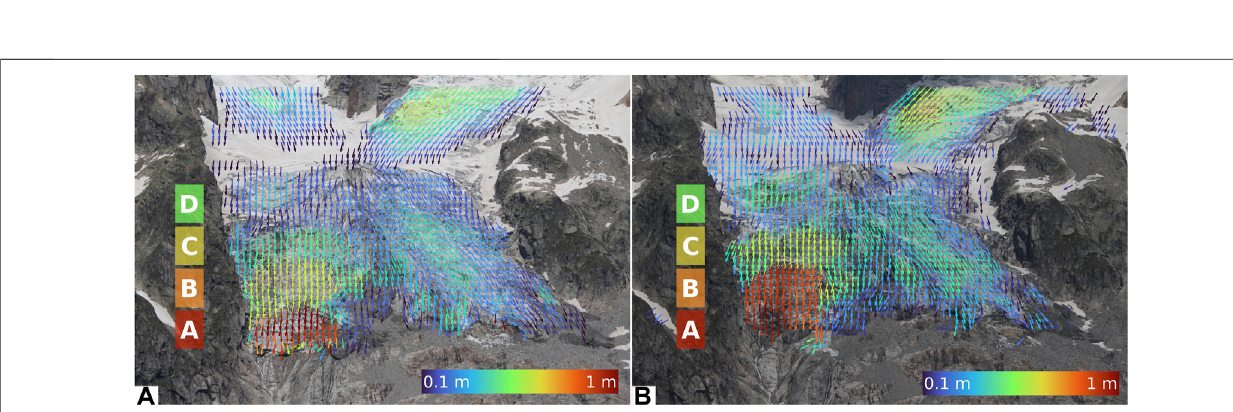
FIGURE 9 | (A) Daily surface displacement between 7 and 14 August 2016. The map evidences the presence of four distinct kinematic domains in the Montitaz Lobe, with displacement rates increasing toward the terminus. (B) Daily surface displacement between 29 and 1 August 2020. The kinematic domains “ A ” and “ B ” are merged and move with similar